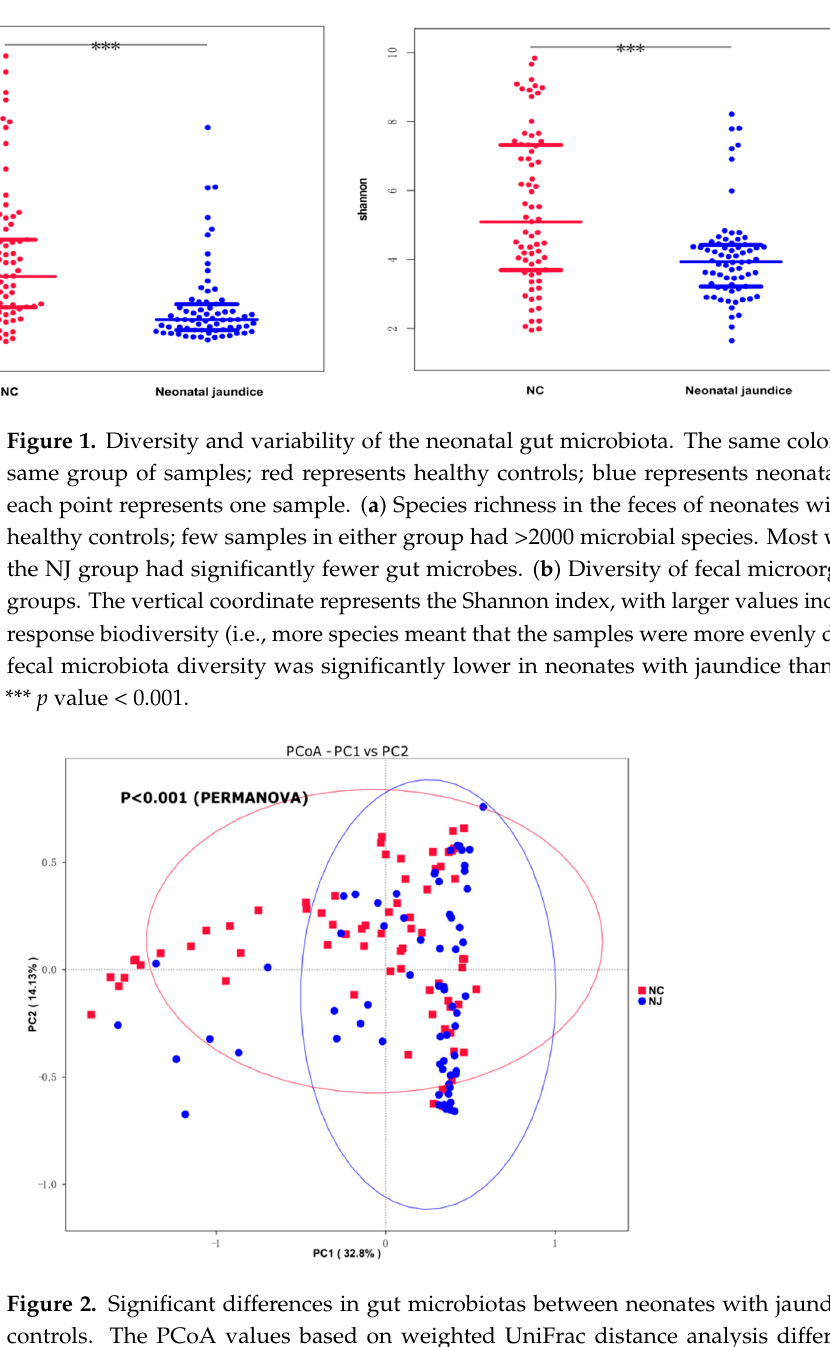
Figure 2. Significant differences in gut microbiotas between neonates with jaundice and healthy controls. The PCoA values based on weighted UniFrac distance analysis differed significantly be- tween the two groups, and the differences in gut microbiota compositions were significantly higher in the control group (PC1; 32.8%) than in the jaundice group (PC2; 14.13%) by nonparametric mul- tivariate ANOVA ( p < 0.001